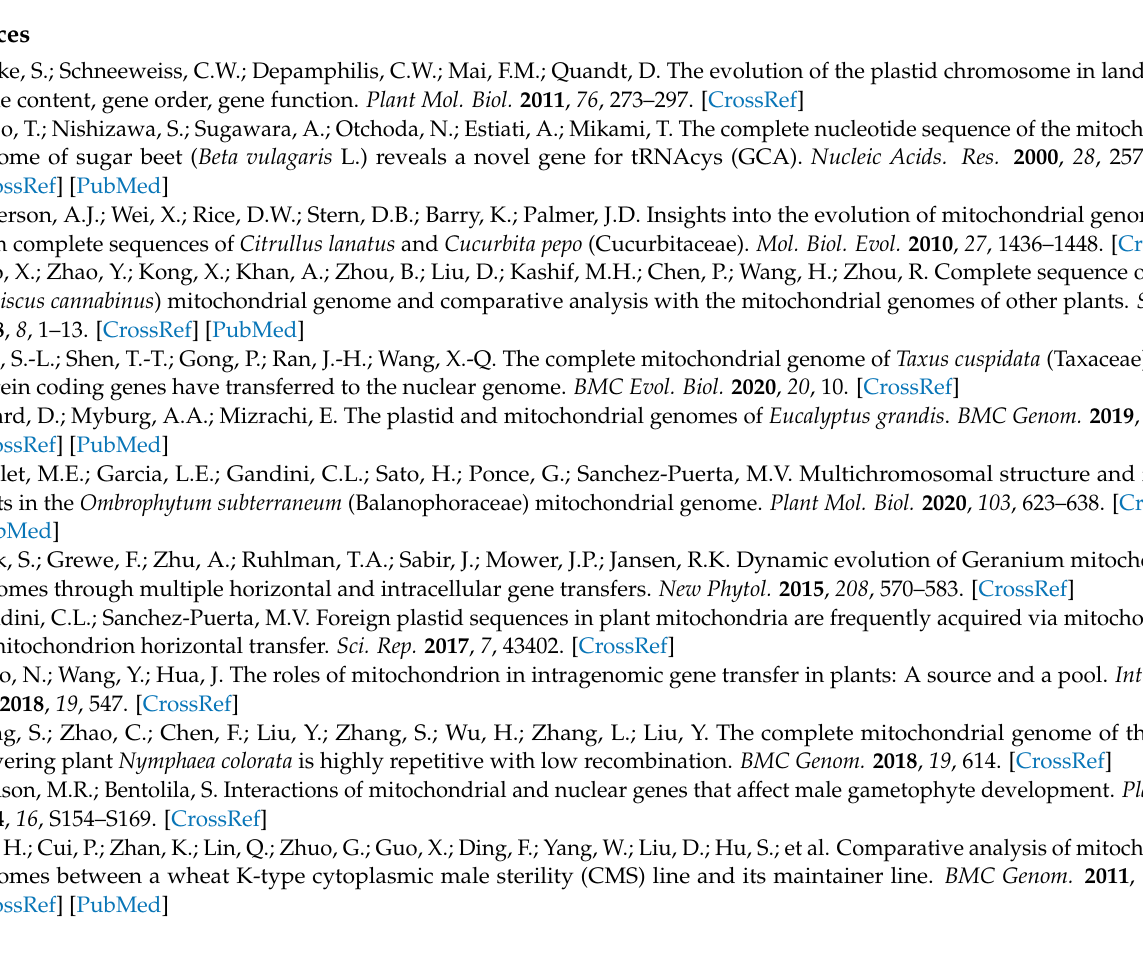
Table S8: Candidate CMS genes in A. indica mitochondrial